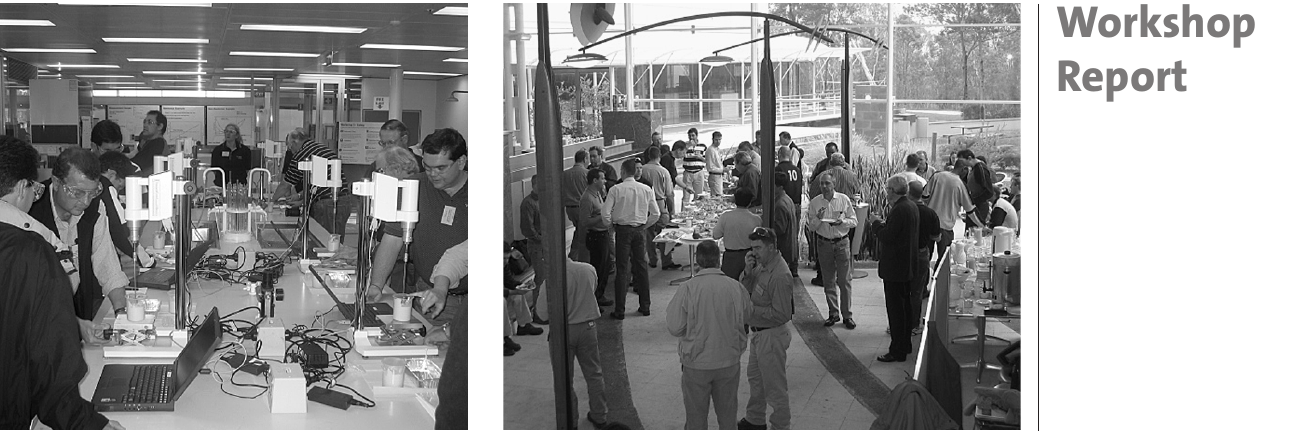
Figure 2 (left): Attendees took full advan- tage of Rio Tinto’s state-of- the-art laboratories by engaging in rheology measurements and manipulation exercises. Figure 3 (right): The ACG’s First Mineral Processing and Tailings Rheology Workshop attracted more than 50 professionals and researchers from all over the world, including South Africa, Botswana, Alaska, Chile and Canada.